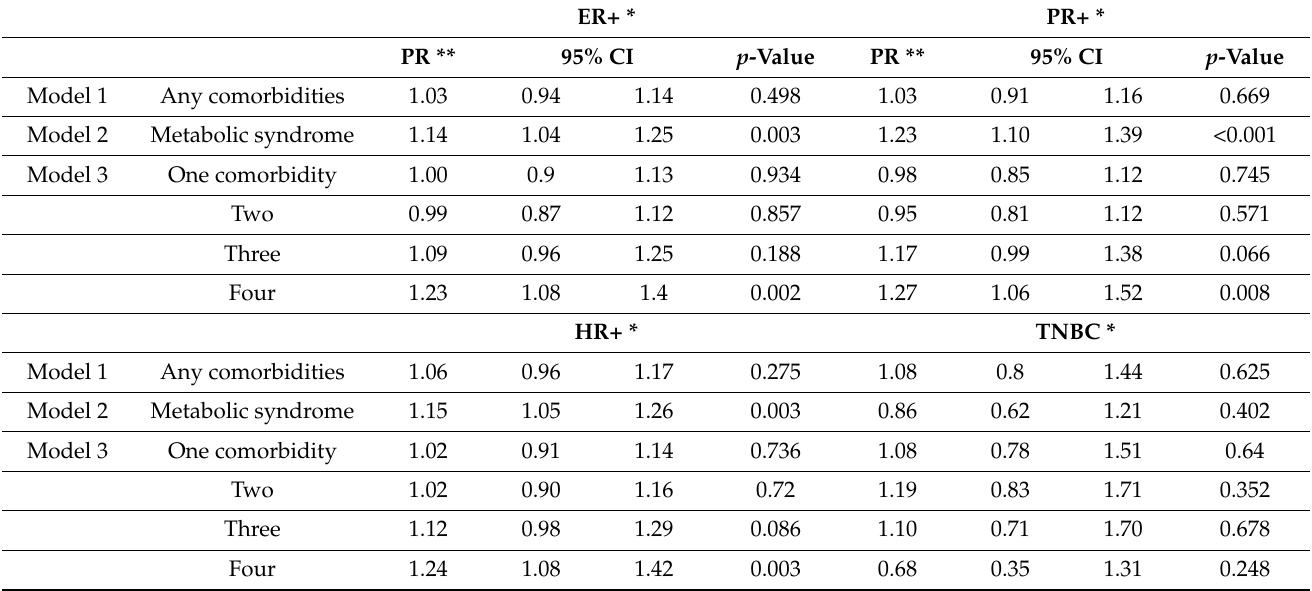
Table 3. Adjusted association of comorbidities with breast cancer subtypes (ER, PR, HR, and triple negative). ER+ * PR+ * PR ** 95% CI p -Value PR ** 95% CI p